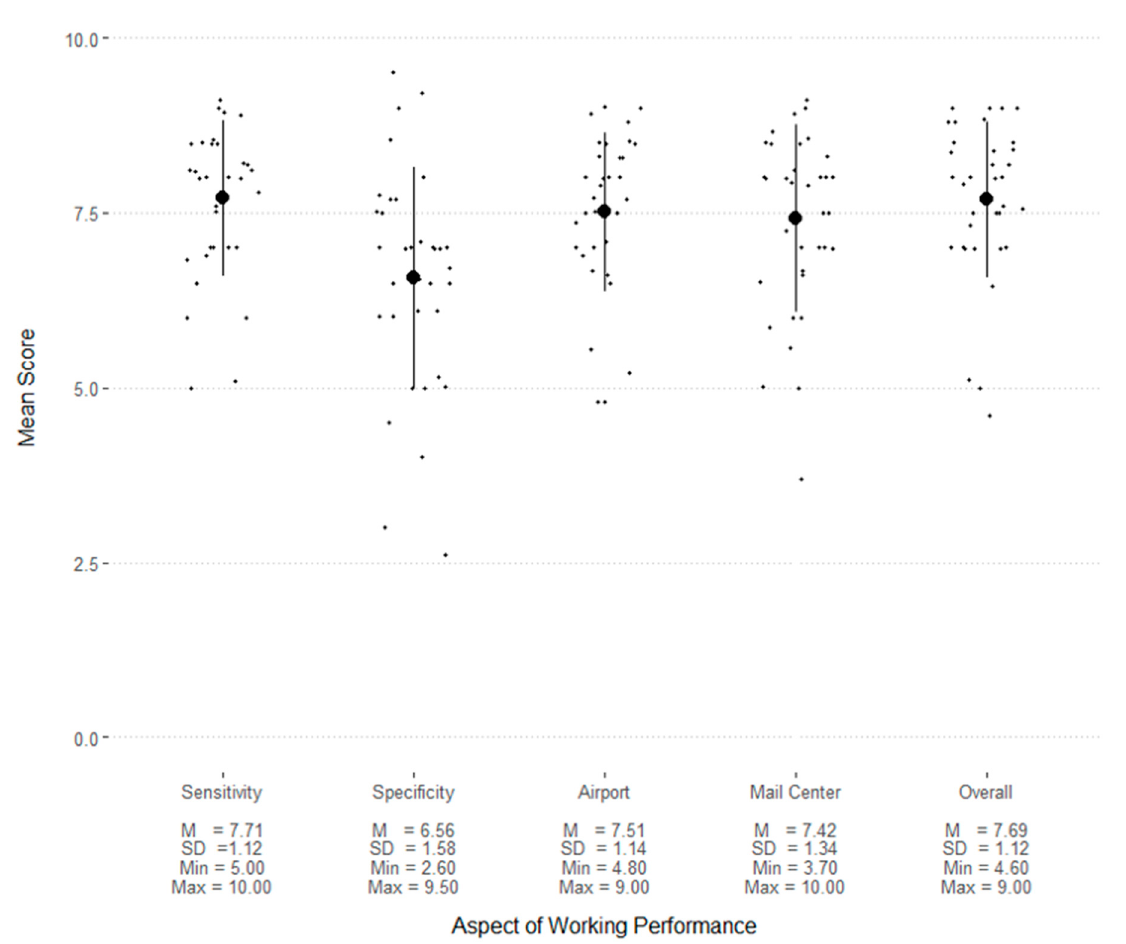
Figure 3. Working performance scores, where 0 indicates poor and 10 indicates excellent. The circles indicate the mean and lines indicate the standard deviation. Each point is an individual dog’s score.